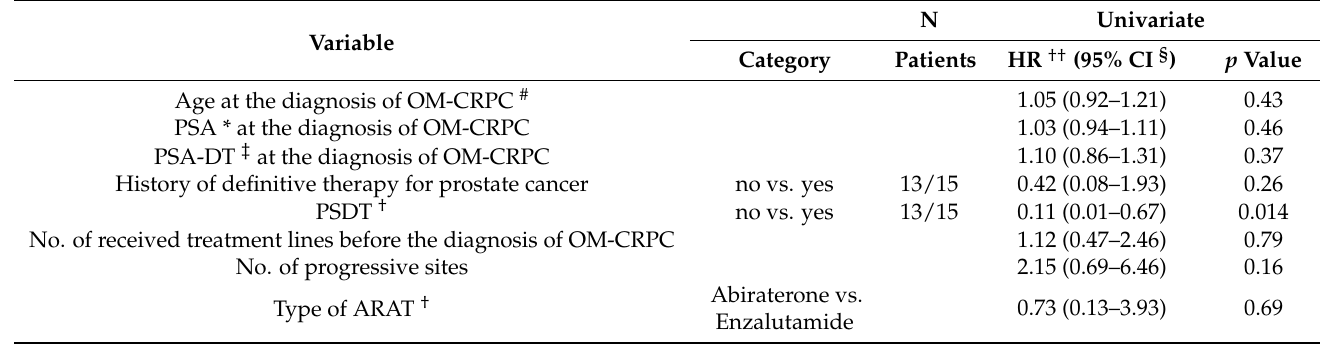
Table 3. Cox hazard model to identify factors predictive of overall